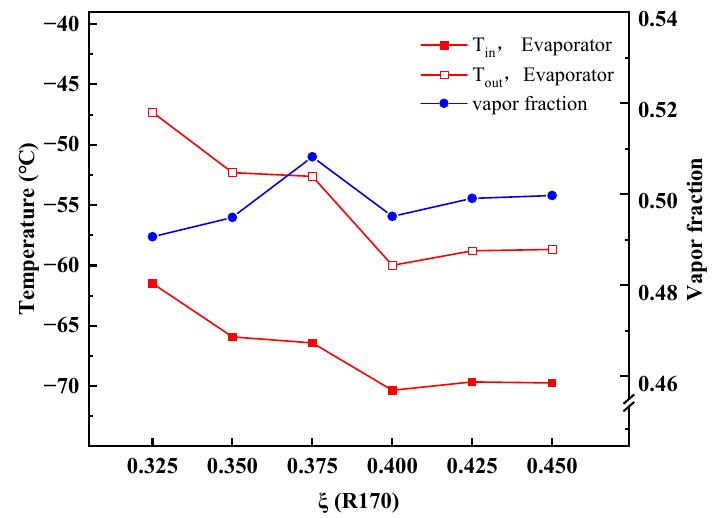
Figure 4. Parameter changes in and out of the evaporator.